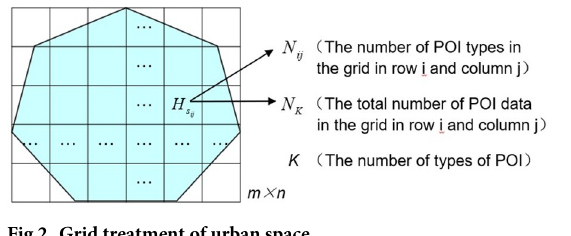
Fig 2. Grid treatment of urban